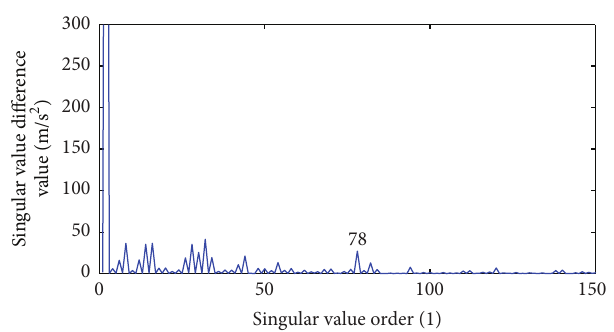
Figure 5: Singular value differential spectrum.